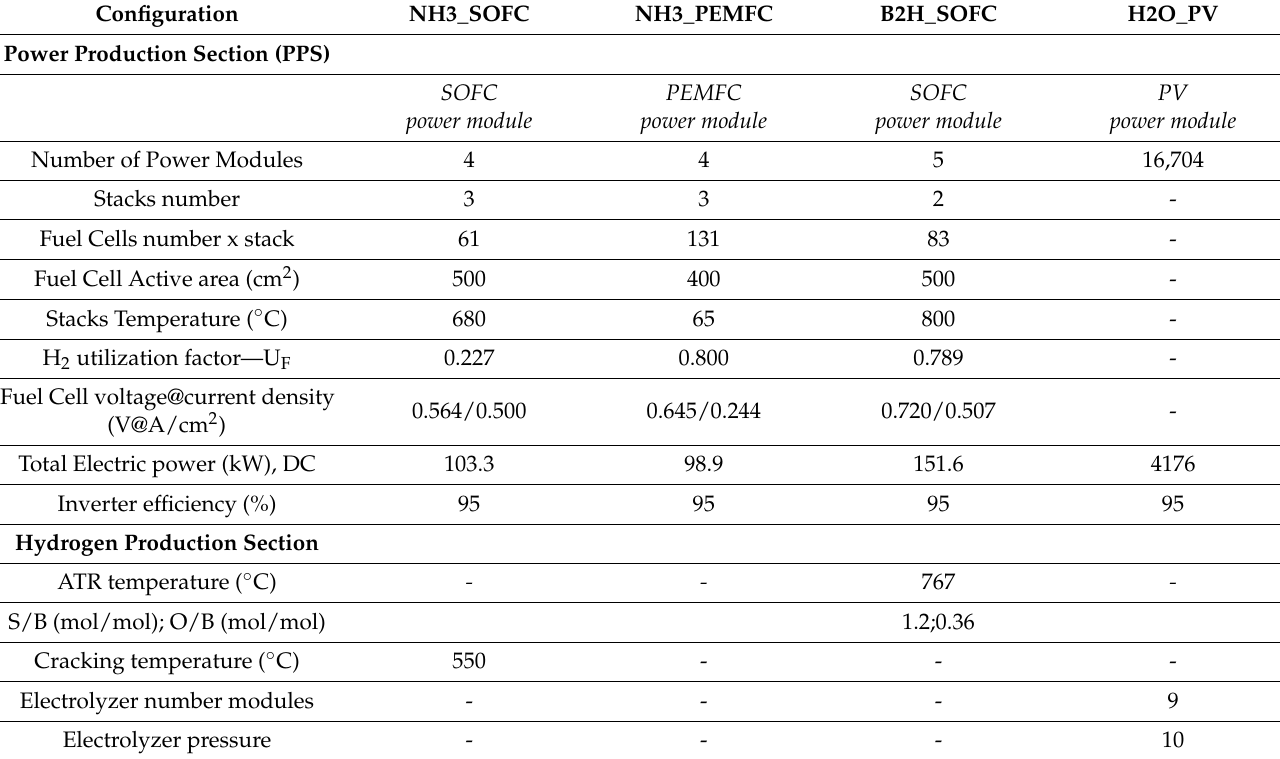
Table 1. Characteristics of the main components for each plant